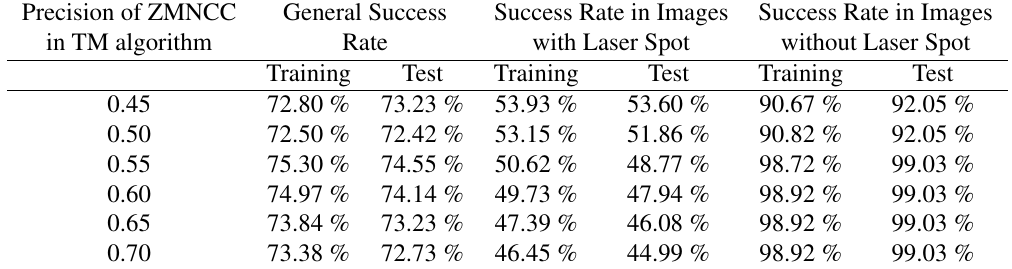
Table 7. Analysis of the influence of the TM precision param- eter for TM + FRBS WM (i.e., RB is automatically generated by the Wang and Mendel algorithm to consider the new example data) when color is still not considered. ZMNCC: Zero Mean Normalize Cross Correlation